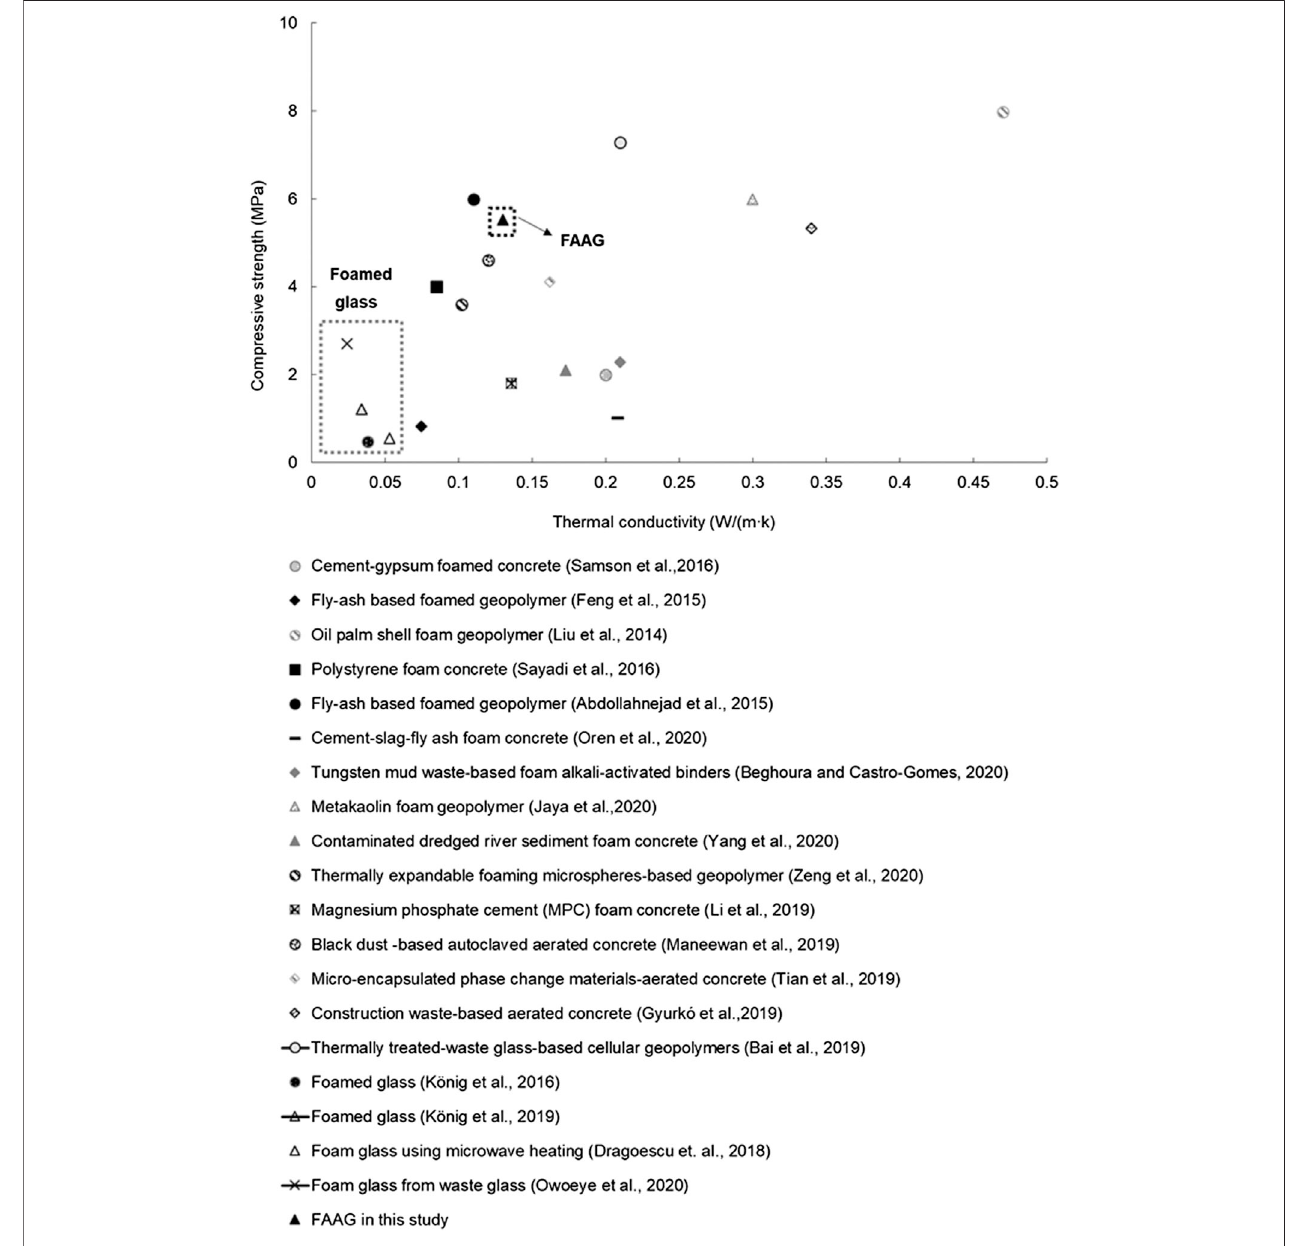
FIGURE 11 | Comparison between the prepared foamed alkali-activated glass (FAAG) and other foamed construction products.